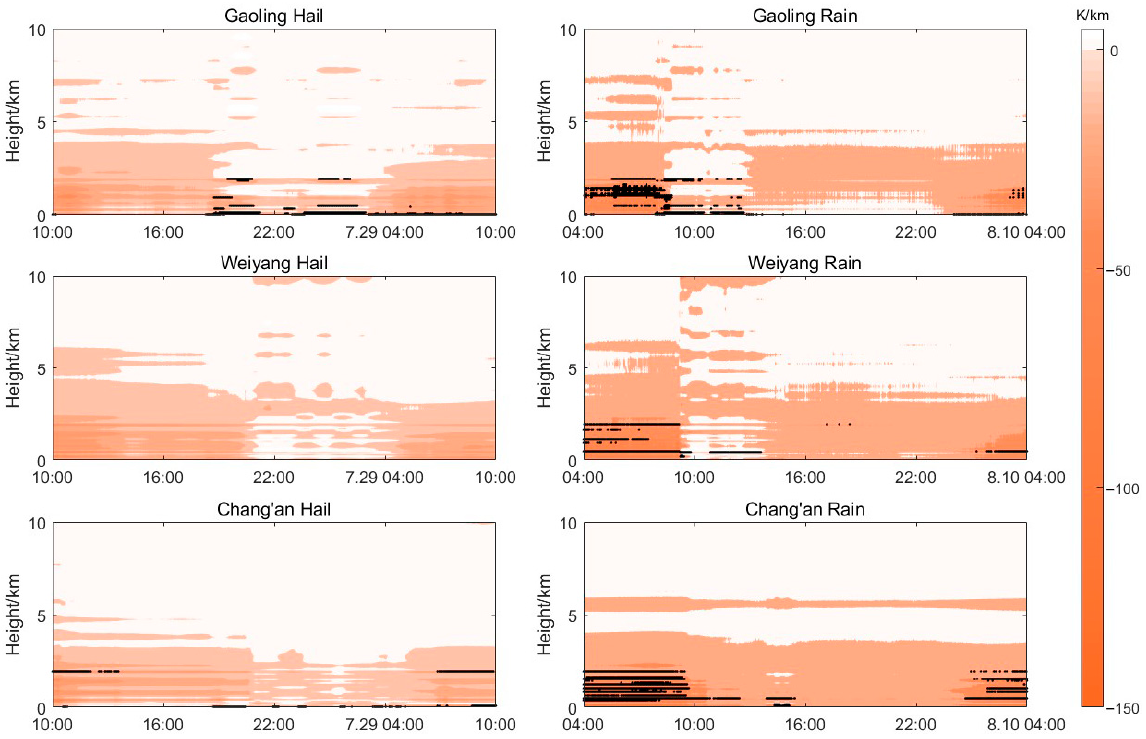
Figure 7. Hailstorms ( left , starting at 4:00 p.m. UTC on 27 July 2019, as shown in Figure 4) and rainfall ( right , rainfall process, starting at 4:00 p.m. UTC on 8 August 2018, as shown in Figure 4) potential temperature (when <0, represented by black dots) gradient and pseudoequivalent potential temperature gradient (filled color) in the Gaoling, Weiyang, and Chang’an districts.